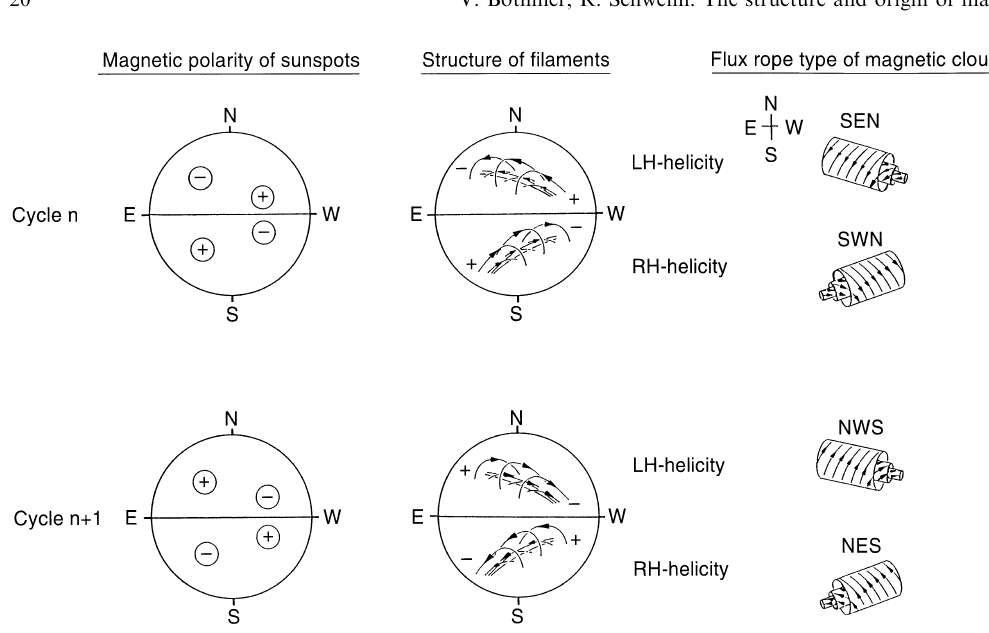
hemispheres and the right panel shows the expected structure of MCs in interplanetary space. During odd ( n ) cycles SN-MCs are dominant whereas NS-MCs dominate during even (cid:133) n (cid:135) 1 (cid:134) cycles (Bothmer and